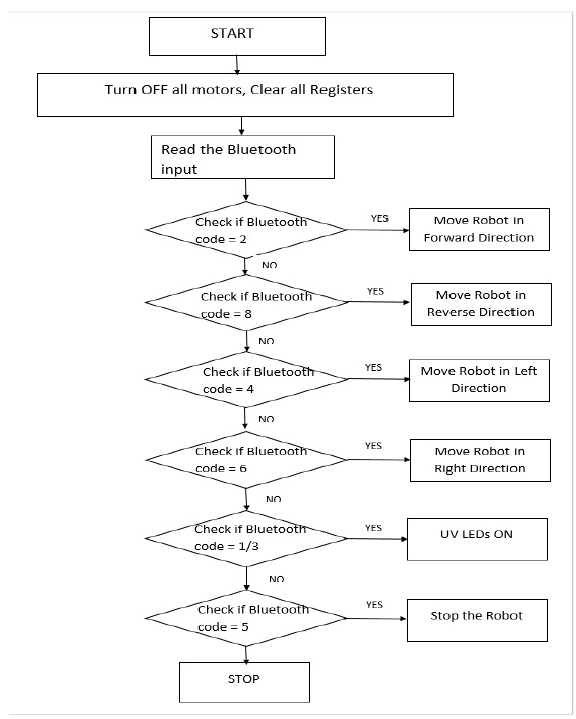
Fig. 2. Flowchart of the Proposed System